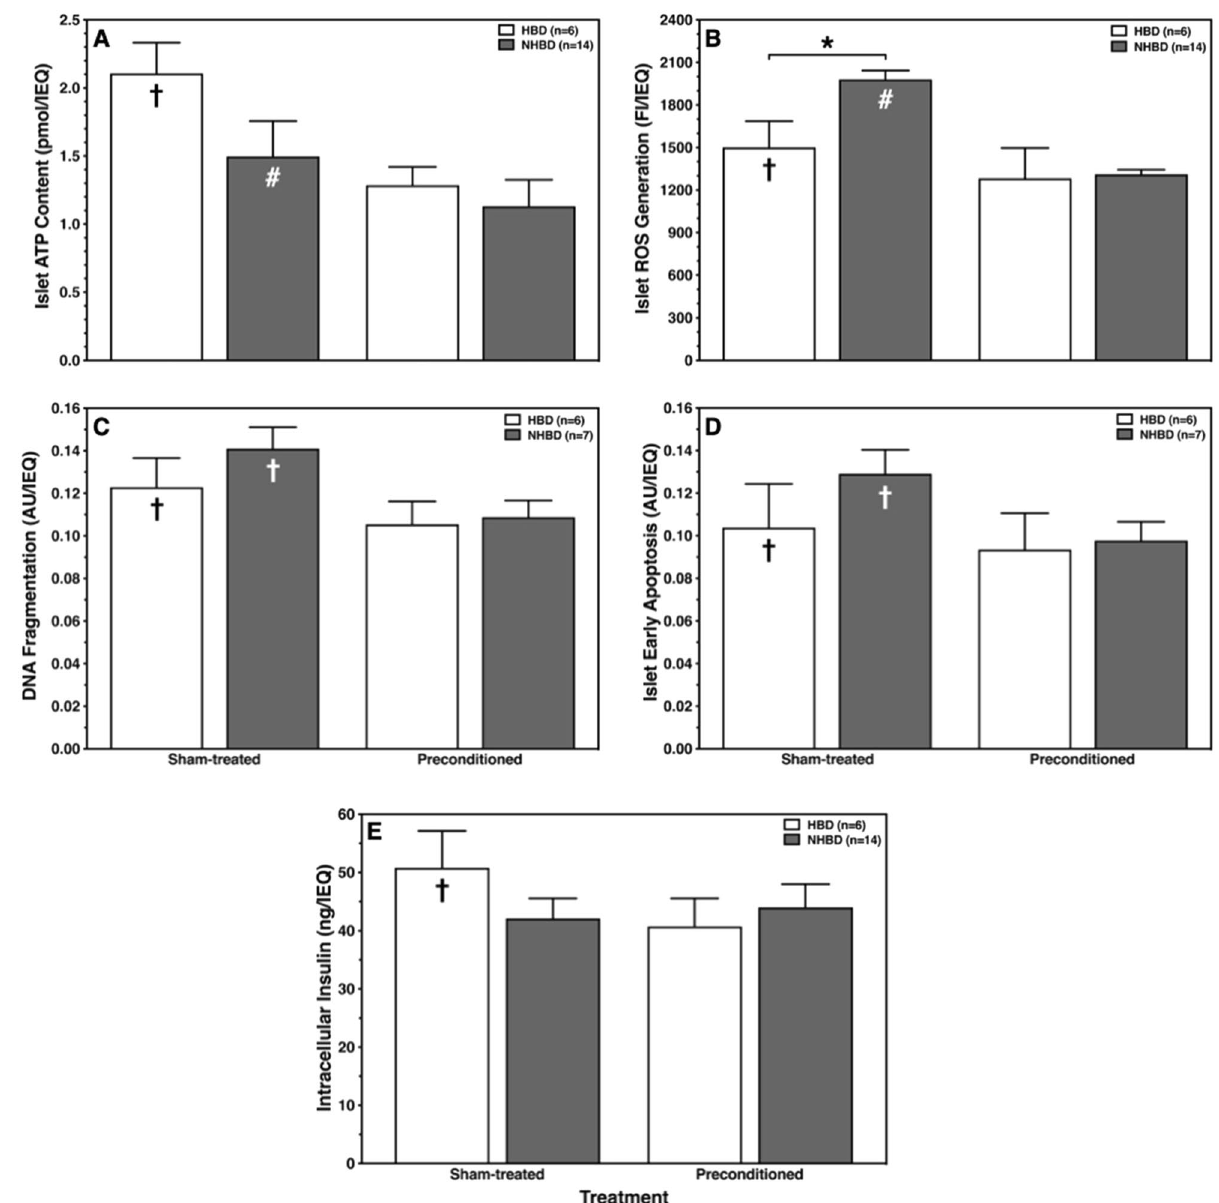
Figure 2. Ex-vivo hypoxic preconditioning stabilises ATP production and reduces ROS generation of ischemically predamaged rat islets. Islets were isolated from heart-beating (HBD, white bars) and non heart- beating donors (NHBD, grey bars). ( A ) ATP content, ( B ) ROS production, ( C ) DNA fragmentation, ( D ) early apoptosis and ( E ) intracellular insulin content were assessed after sham-treatment or preconditioning followed by 24 h-culture of sham-treated or preconditioned islets in hypoxic atmosphere, respectively. * p < 0.05 for HBD versus NHBD. Symbols inside bars indicate † p < 0.05, # p < 0.001 versus corresponding